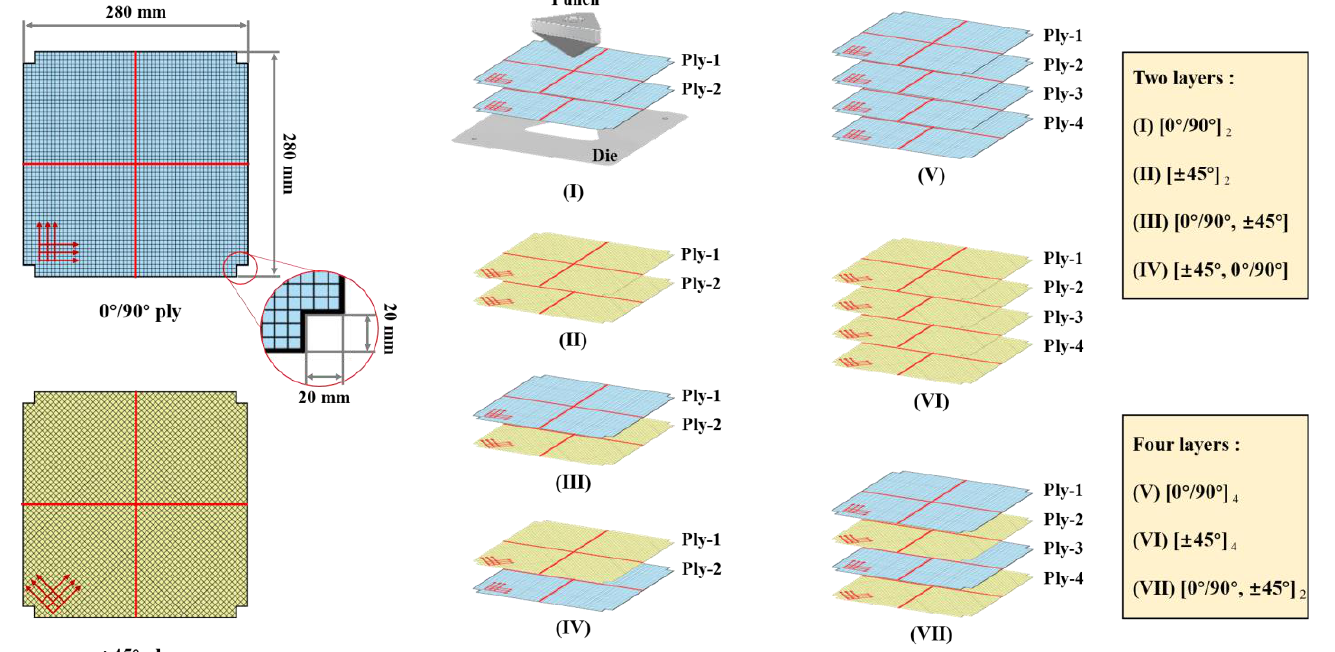
Figure 5. Schematic of specimen size (suitable for hemisphere preforming and tetrahedral preforming) and multi-layer configurations (only for tetrahedral preforming).